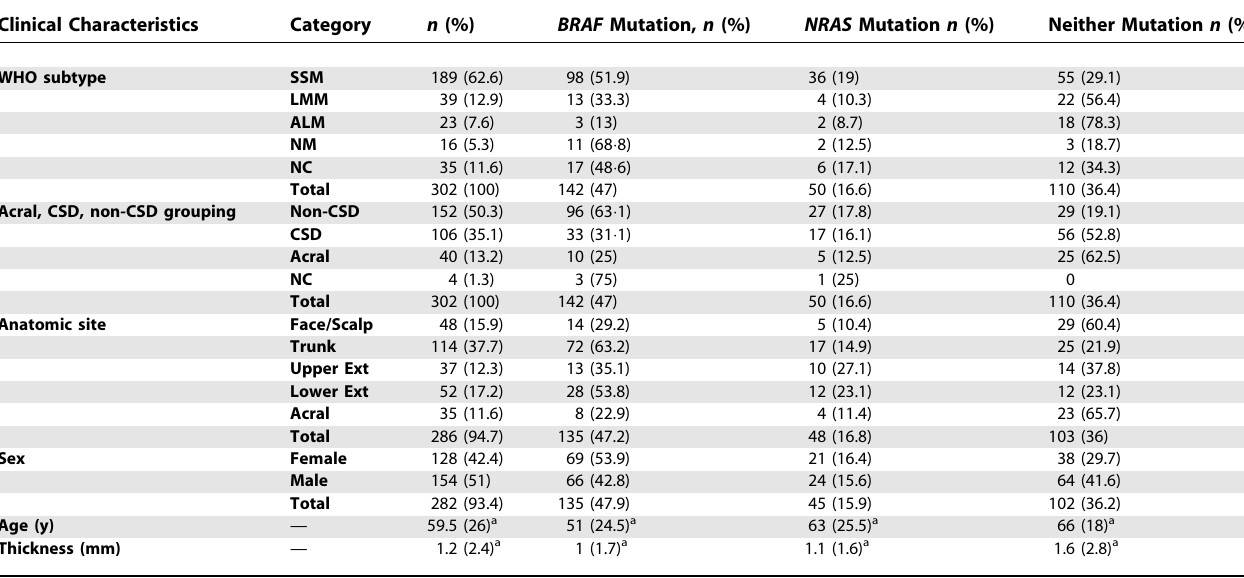
Table 1. Clinical Characteristics of Patients and Melanomas by Mutation Status of BRAF and NRAS Included in Our Analysis Clinical